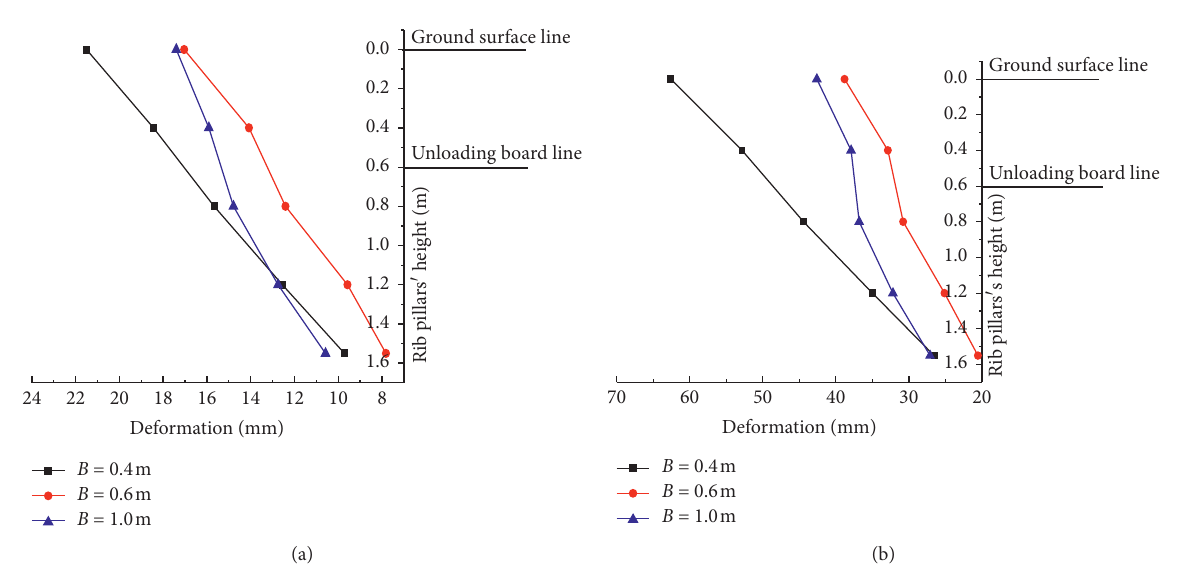
Figure 10: The variation curve of the deformation of rib pillars with the wall body at the external load: (a) h � 0.6m ( p � 10kPa) and (b) h � 0.6m ( p � 50kPa).